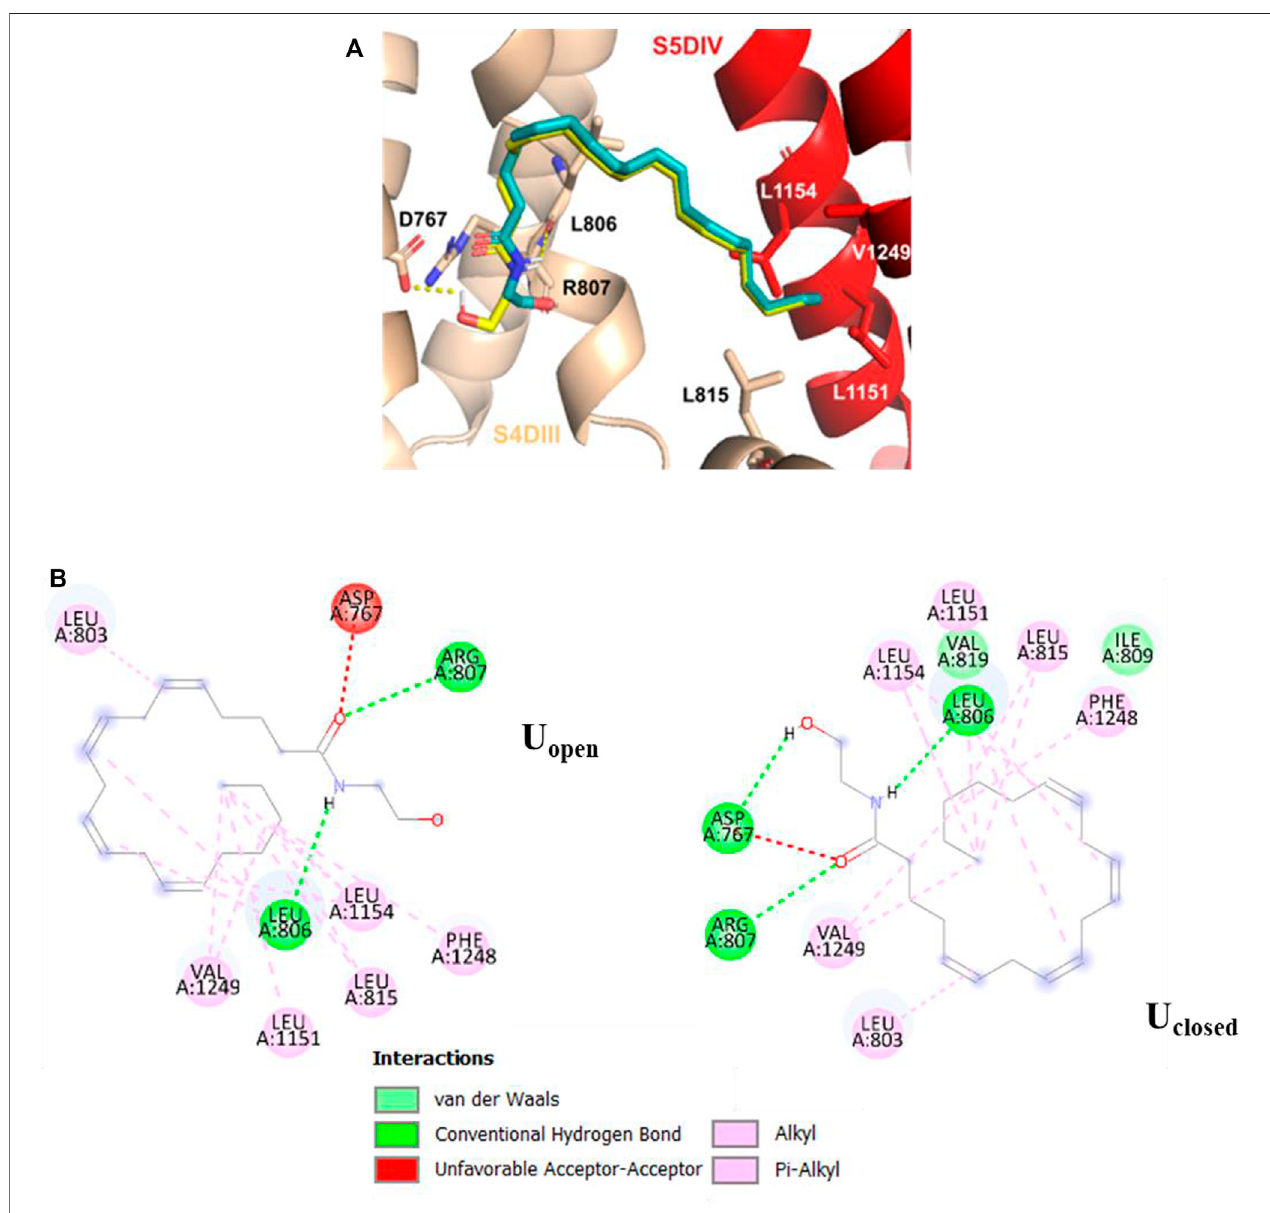
FIGURE 4 | Molecular interactions of U open (cyan) and U closed (yellow) anandamide conformers with Ca v 3.2. (A) 3D perspective of S5DIV site, U closed and U open conformers forming two hydrogen bonds with residues L806 and R807, U closed additionally forms a hydrogen bond with D767 (B) 2D perspective interaction for each anandamide conformer in the S5DIV